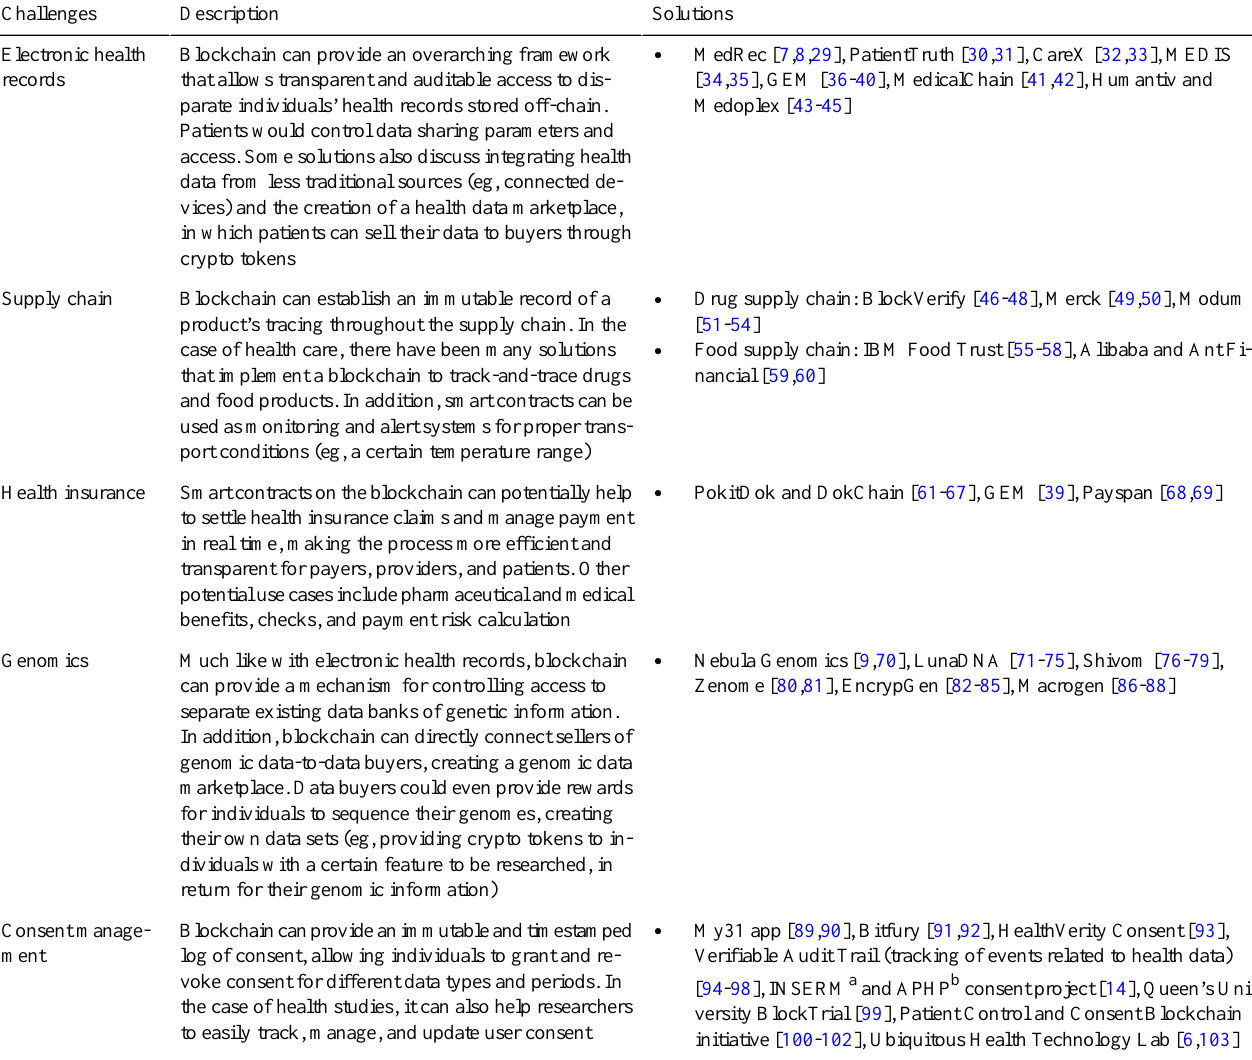
Table 1. Results of the literature review.